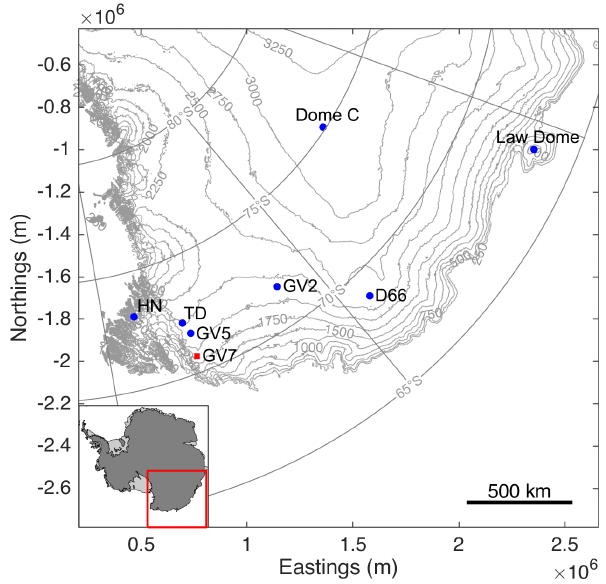
Figure 1. GV7 (70 ◦ 41 (cid:48) 17.1 (cid:48)(cid:48) S, 158 ◦ 51 (cid:48) 48.9 (cid:48)(cid:48) E; 1950ma.s.l.) drilling site (red square). Hercules Nevé (HN), Talos Dome (TD), GV5, GV2, D66, Dome C and Law Dome ice core drilling sites are also shown (Greene et al., 2017; Fretwell et al.,